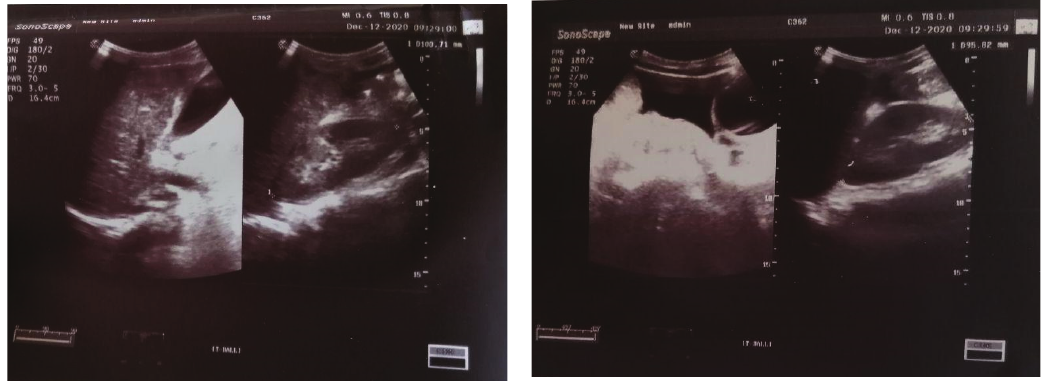
Figure 1 : Abdominal ultrasound showing enlarged liver with cirrhotic changes and moderate-to-massive